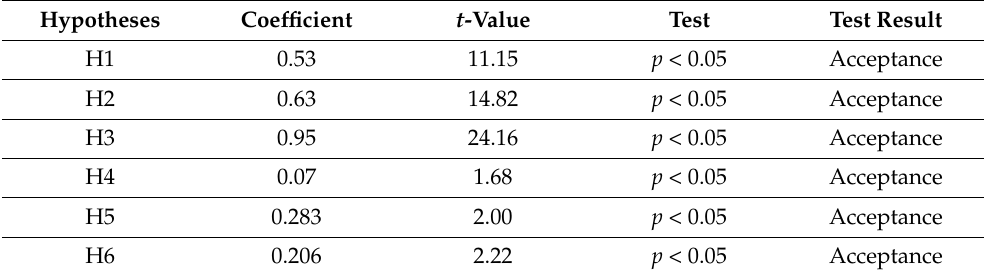
Table 7. Tested results of the